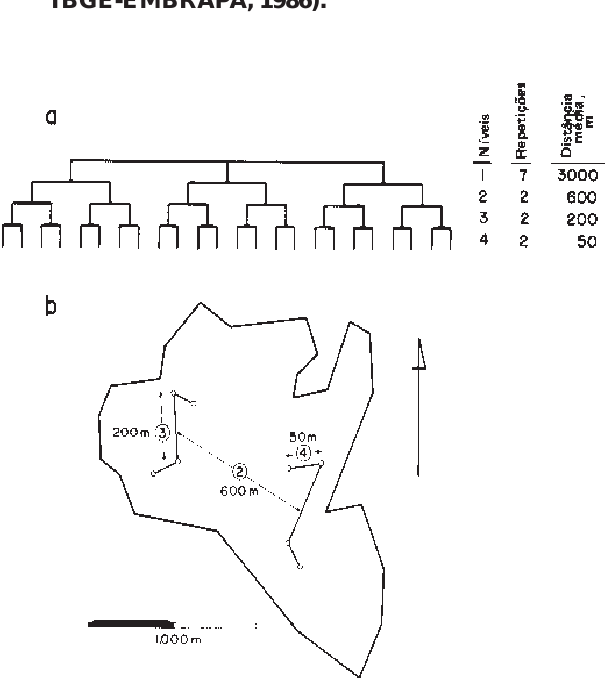
Figura 2. Ilustração do esquema de amostragem adotada: a) hierarquia de amostragem, b) distribuição espacial dos pontos de amostragem na gleba